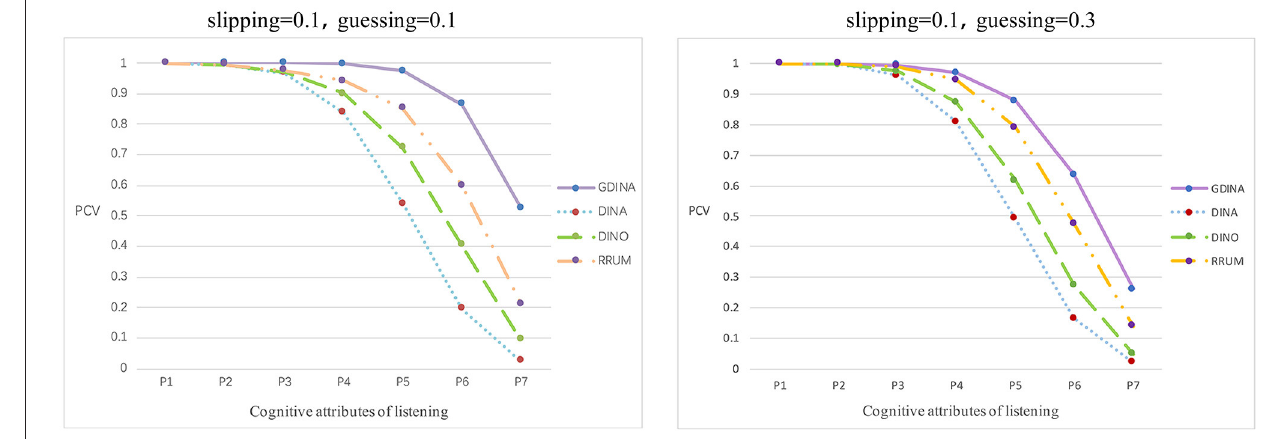
FIGURE 3 | Average proportion of correctly classified attribute vectors.